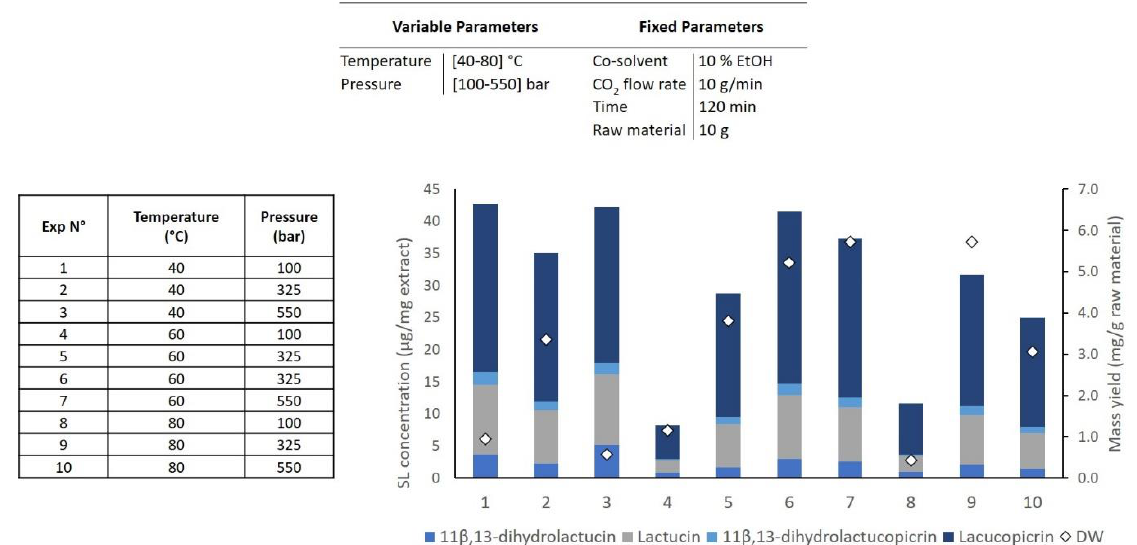
Figure 2. The extraction of SL was carried out following a Central Composite Face-Centered Design (DOE #1) as a function of pressure and temperature. Experiment numbers (1–10) correspond to the extraction number assay, white diamonds (values linked to right axis) represent extraction mass yield and coloured bars (values linked to left axis) represent the concentration of the major SLs extracted from Cichorium intybus L . roots from supercritical CO 2 extraction process.